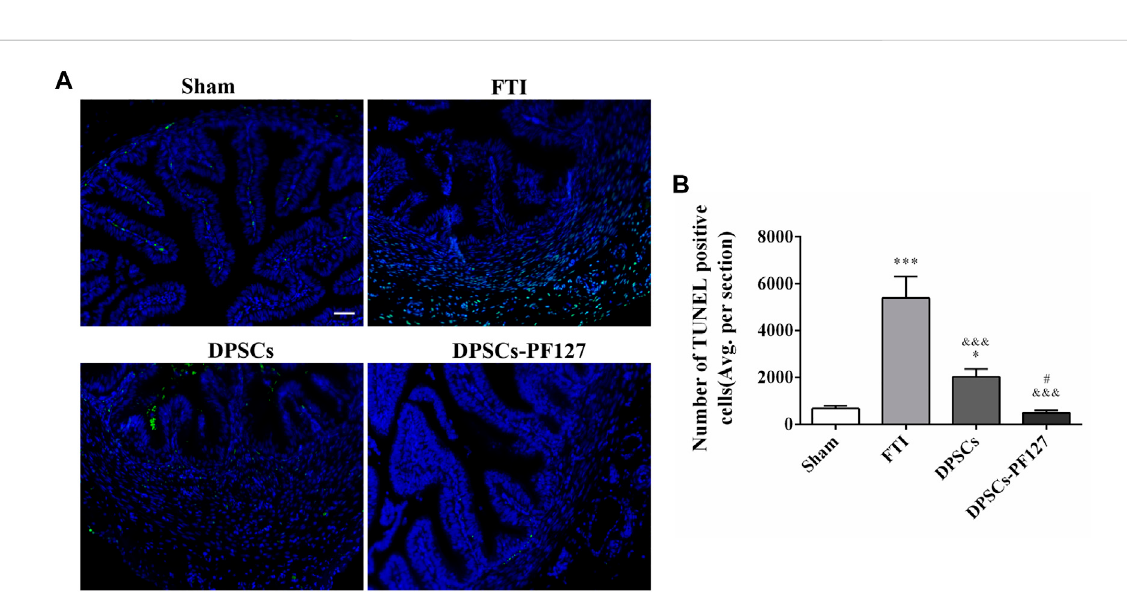
FIGURE 6 DPSCs-PF127 reduces cell apoptosis of the FT at 4 weeks after injury. (A) Immuno fl uorescence staining for TUNEL (green) of sections from the FT in each group. Scale bar: 50 µm. (B) Quantitative estimation of apoptotic and TUNEL cells from three independent sections. All data represent Mean values ±SEM. * p < .05, *** p < .001 versus the Sham group. &&& p < .001 versus the FTI group. # p < .05 versus the DPSCs